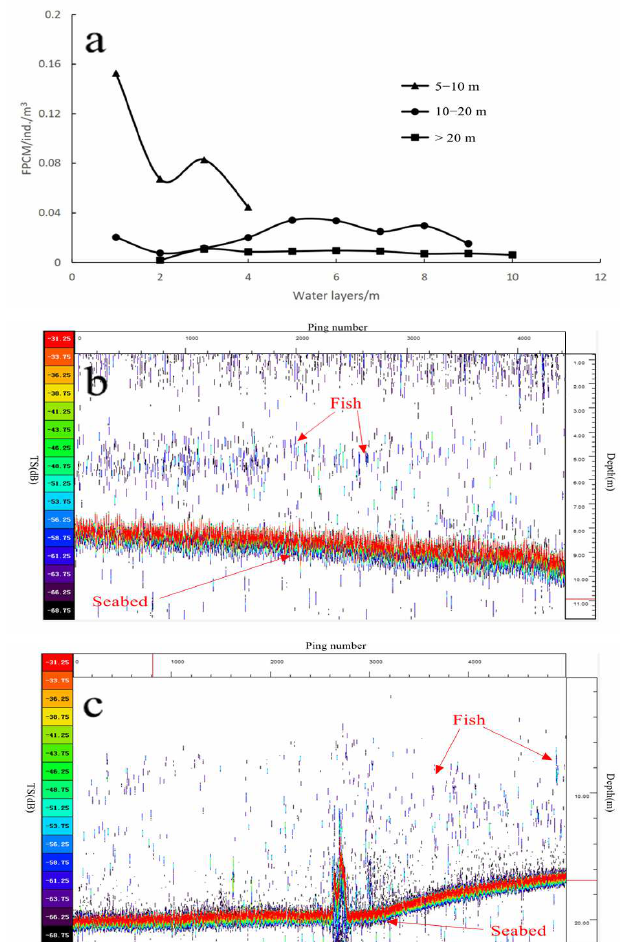
Figure 5. ( a ) Vertical distribution of fish density, ( b ) fish distribution in echogram (depth < 10 m), ( c ) fish distribution of in echogram (depth > 10 m). TS echograms are presented with a 40 log TVG.